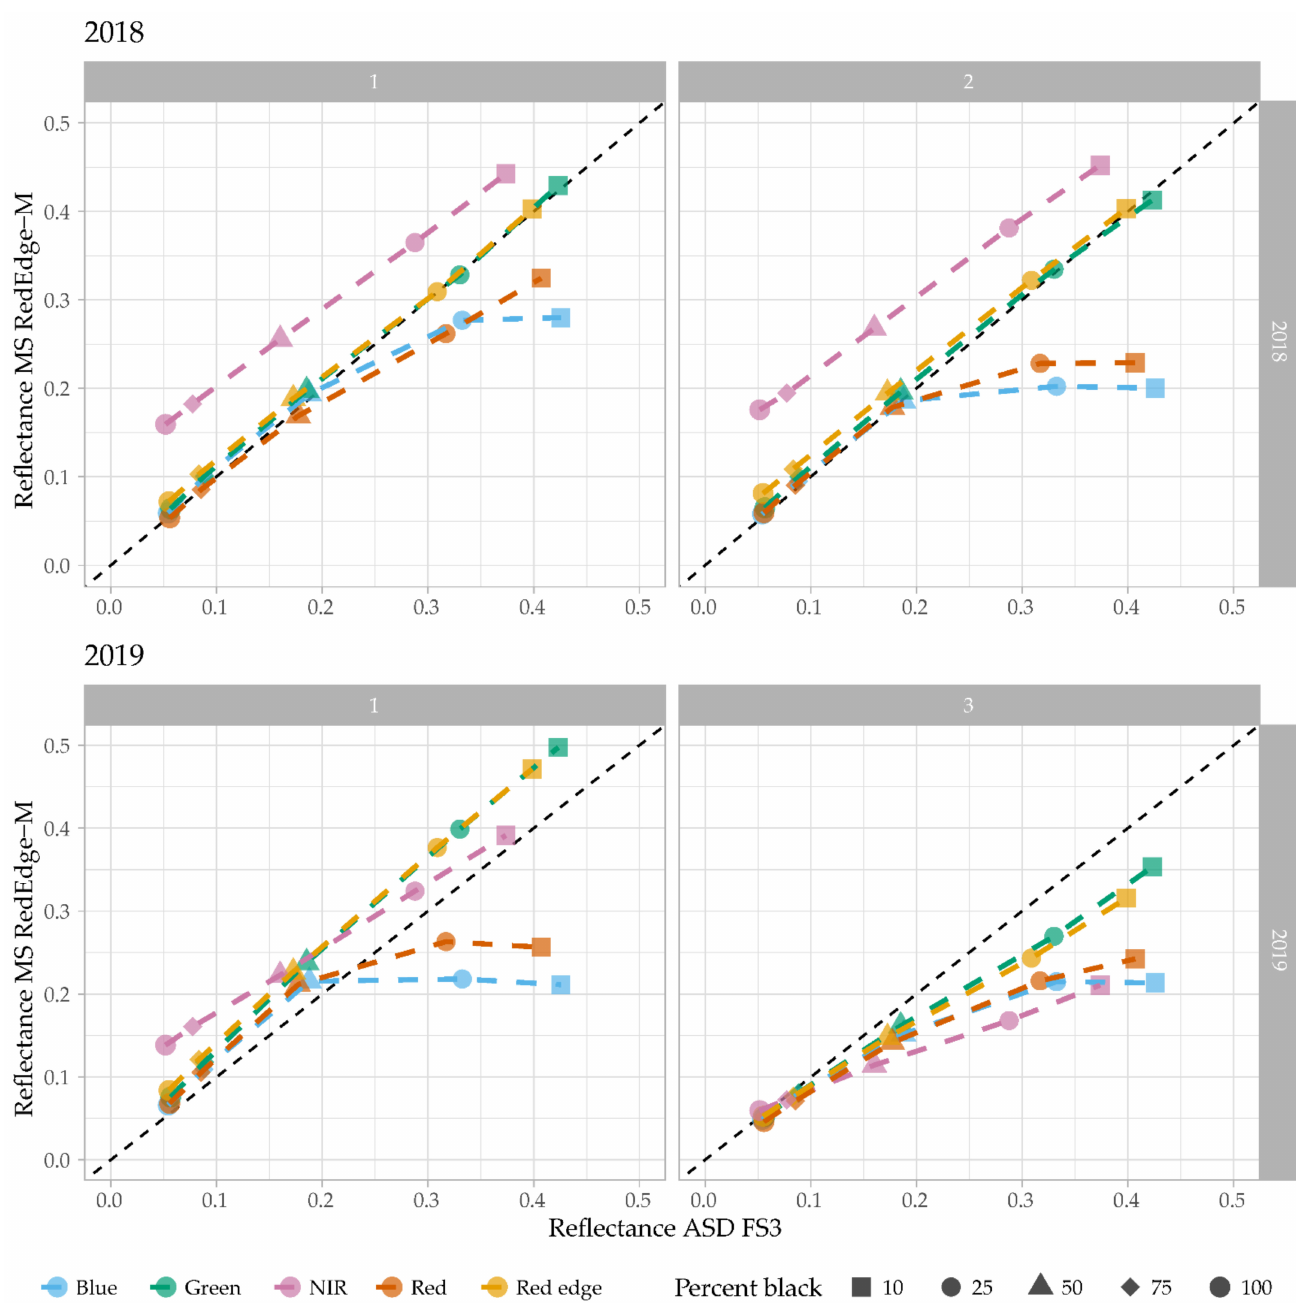
Figure 10. Scatterplot of values for MS camera and ASD Fieldspec 3 measurements of reference panels. Table 7 presents the R 2 and RMSE between the spectroradiometer measurements and the MS camera of the reference panels. In particular, the blue and red bands show weaker relationships with the ASD FieldSpec3 measurements (R 2 0.58–0.74 and 0.69–0.88, respectively). As mentioned above, these low R 2 values are due to the saturation effect above 0.2% reflectance. On the other hand, the red edge and NIR bands show the best agreement with the benchmarking